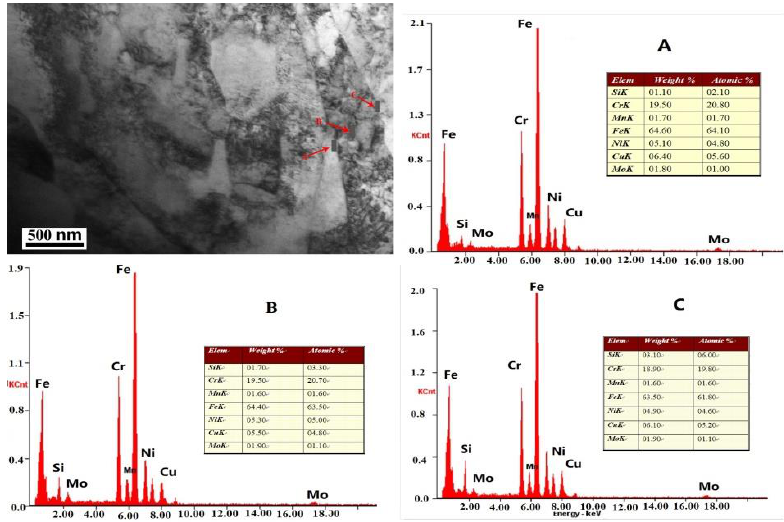
Figure 9. TEM microstructure and EDS spectra of the sample in regions A, B and C with the strain of 0.5.